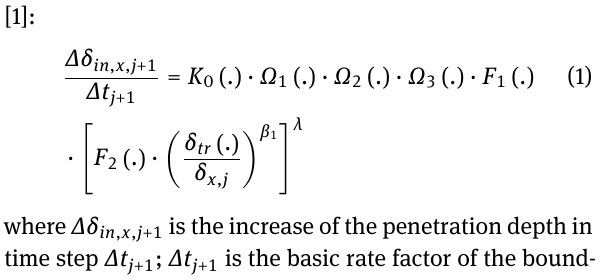
Table 1: Chemical compositions of ASTM type I cement Compound